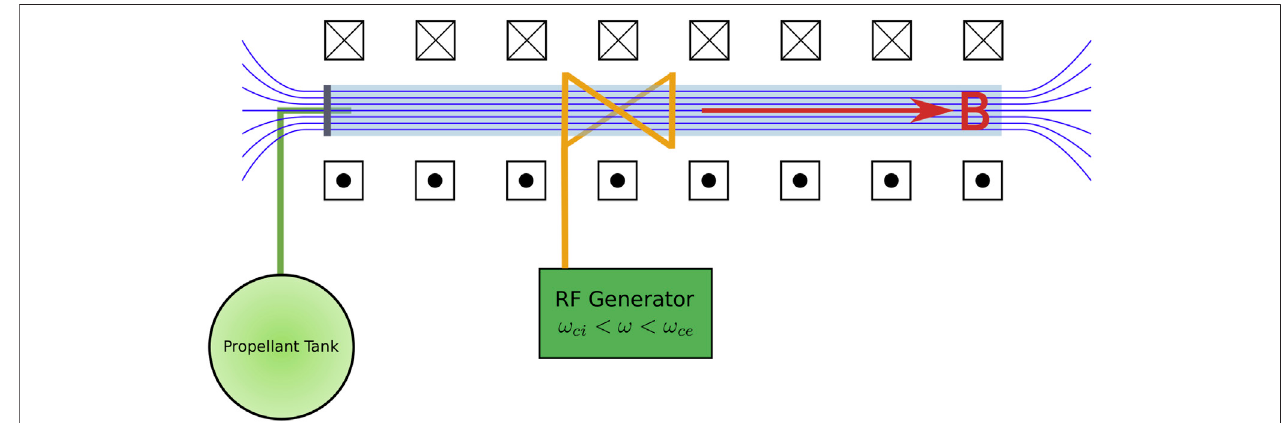
FIGURE 6 | Simpli fi ed representation of a typical implementation of a Helicon Plasma